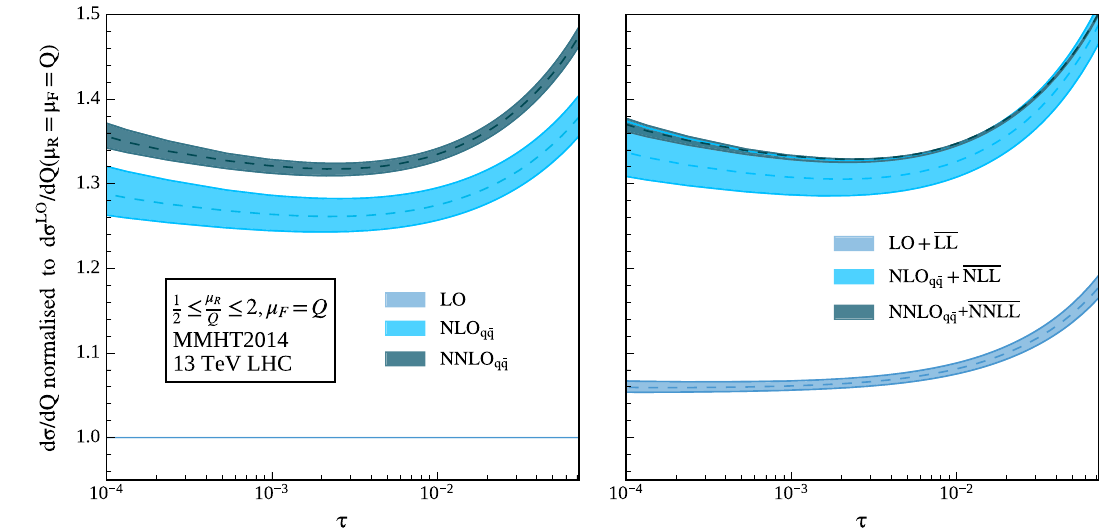
Fig. 8 μ R scale variation of the resummed results against the fixed-order with the scale μ F held fixed at Q for q ¯ q -channel for 13 TeV